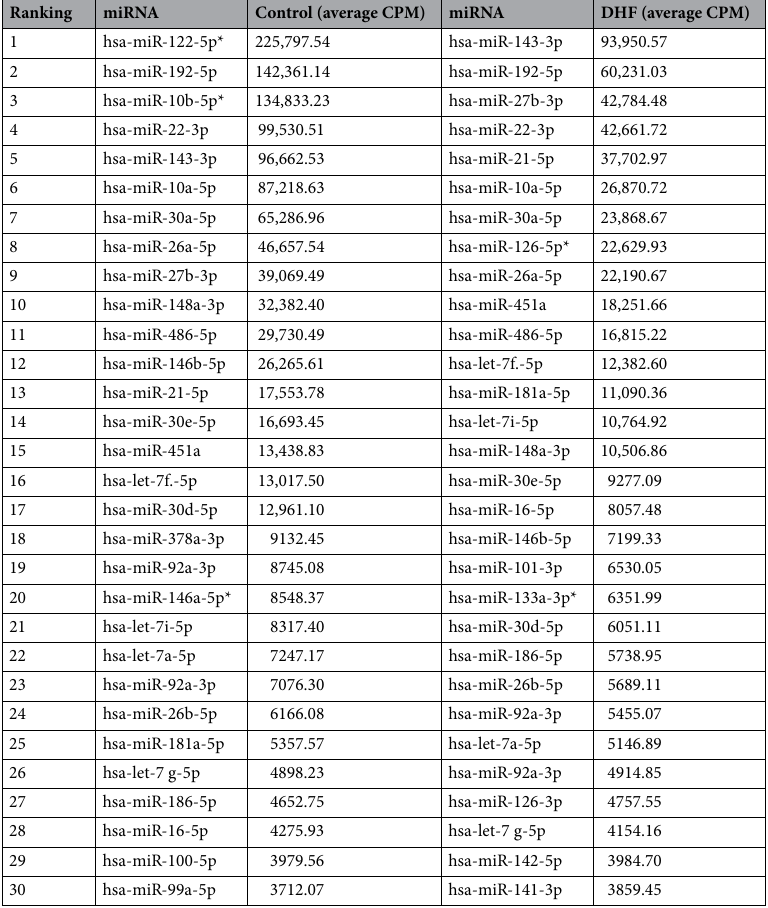
Table 2. Top 30 microRNAs most expressed in hepatic tissue of dengue hemorrhagic fever (DHF) and controls, expression is presented by counts per million (CPM). *Statistically